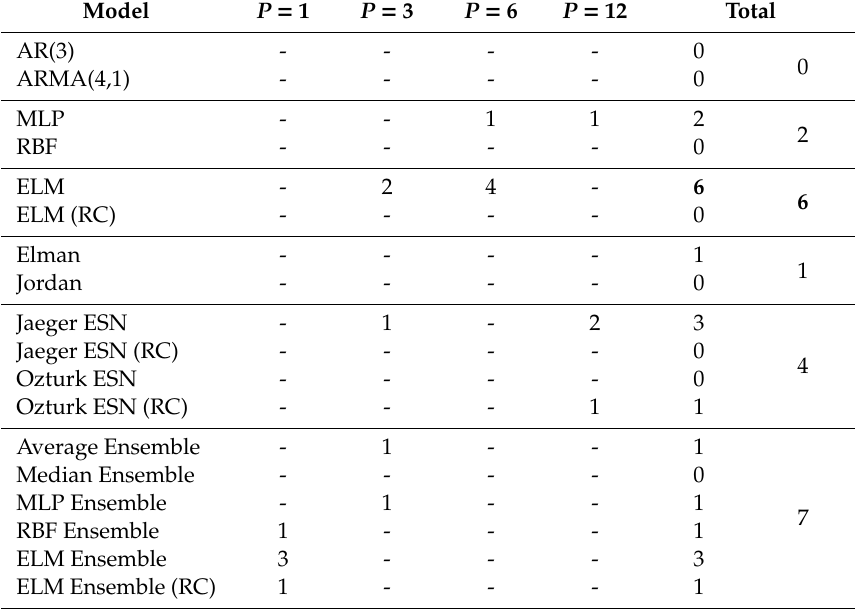
Table 7. Best model by horizon.